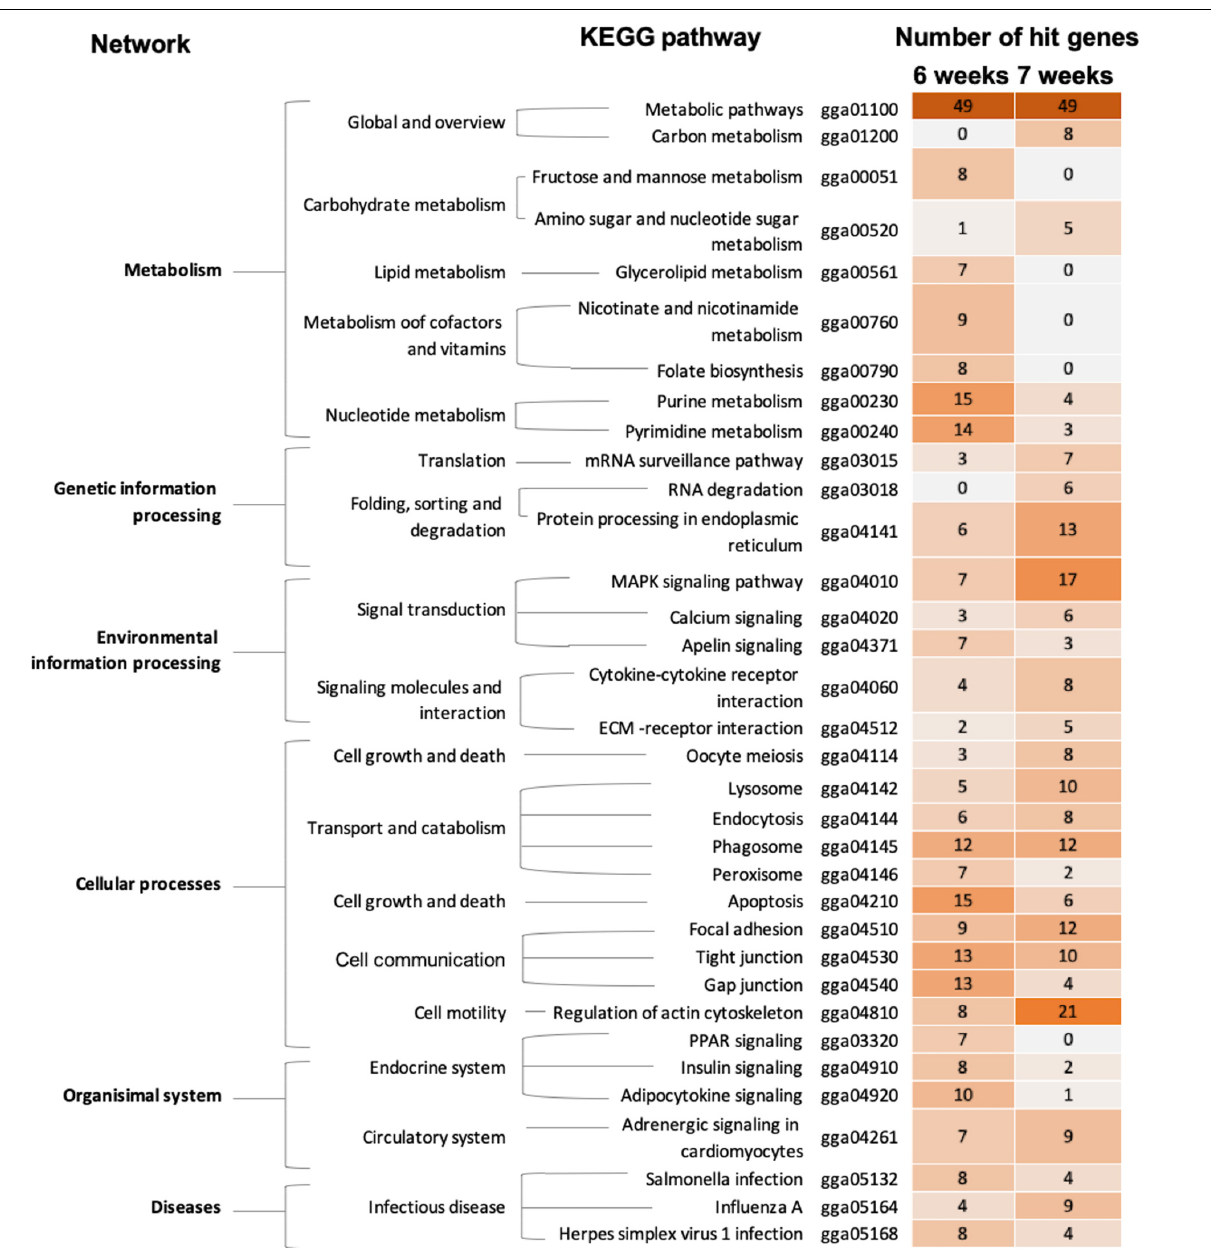
FIGURE 3 | The enriched biological pathways associated with wooden breast (WB) myopathy in 6-week-old and 7-week-old broilers. Heatmap depicts the enriched altered biological pathways, which were further grouped into biological networks, based on KEGG database. The darker color indicated more numbers of differentially expressed genes mapped into the